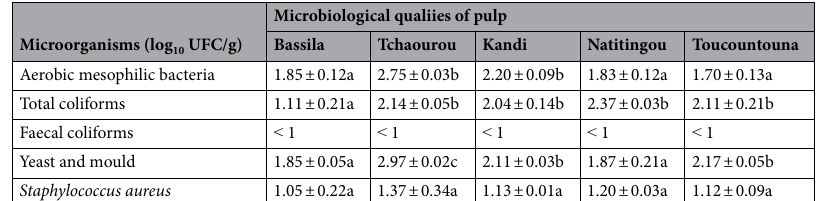
Table 5. Microbiological qualiies of P. butyracea fruit pulp by park collected in June 2020 in Benin. Mean ± Standard deviation; values with the same letter in the same line, are not significantly different at p <